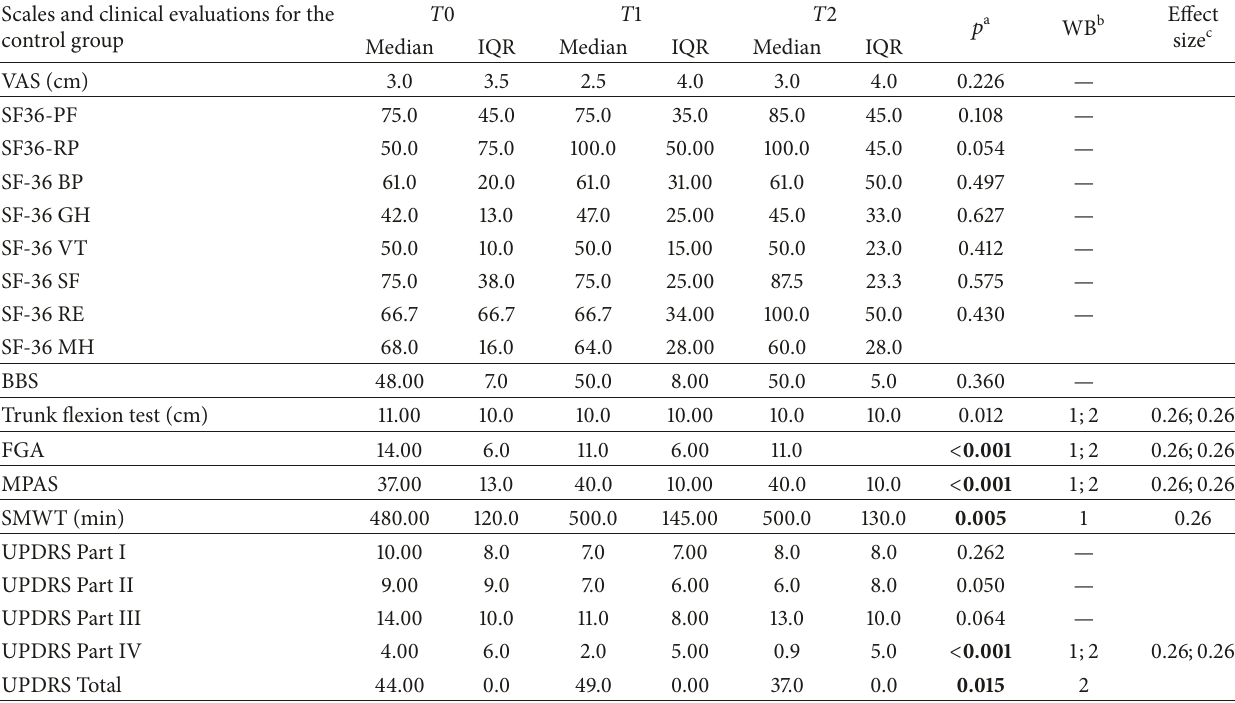
Table 5: Scales and clinical evaluation: comparison for the control group at 3 evaluation times. Scales and clinical evaluations for